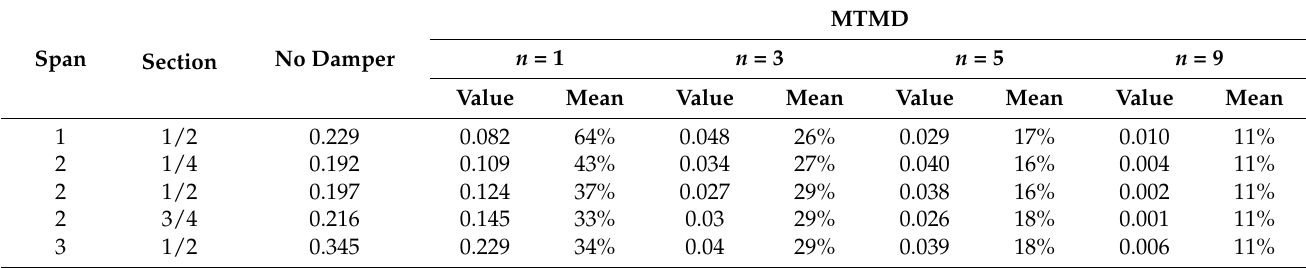
Table 12. Effect of the damper number on the lateral acceleration of the bridge.